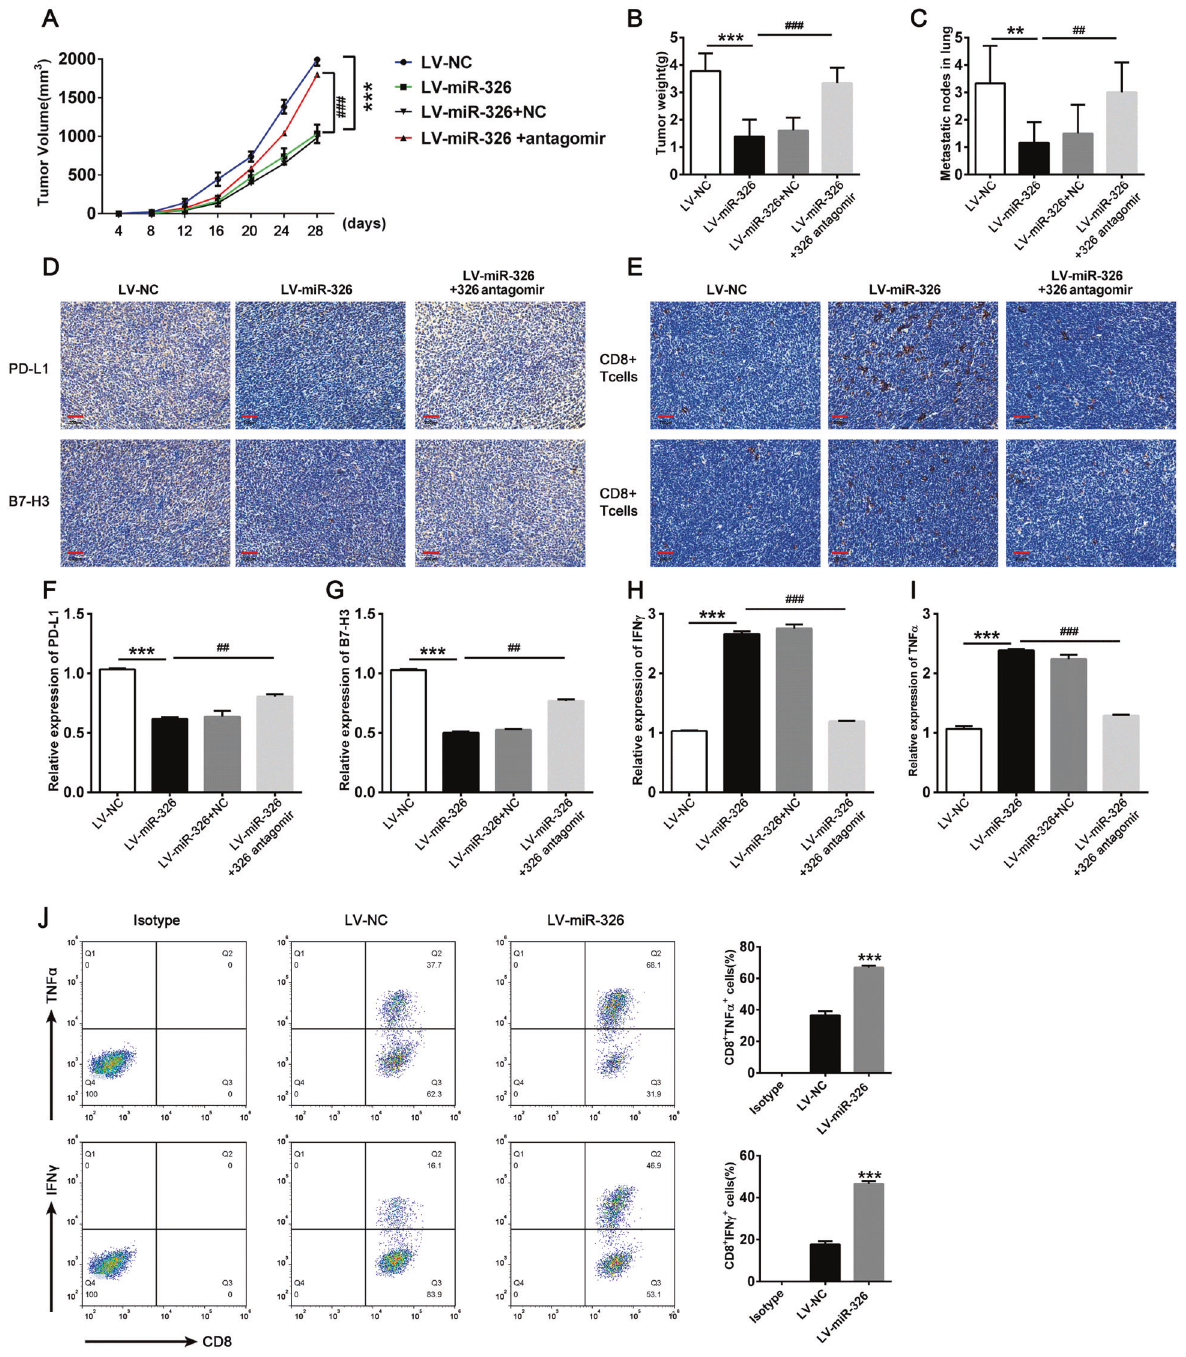
Fig. 6 Overexpression of miR-326 enhances TNF- α and IFN- γ expression of in fi ltrated CD8 + T cells and prevents metastasis by targeting PD-L1 and B7-H3 on cancer cells. 5 × 10 5 miR-326 overexpressed LLC cells or empty vector control LLC cells were subcutaneously injected into C57BL/6 mice. MiR-326 antagomir or NC antagomir were intratumor injected when the tumor diameter reached 0.5 cm. The mice were sacri fi ced 28 days after inoculation. A Tumor volume ( n = 7). B Tumor weight ( n = 6). C Pulmonary metastasis nodule calculated by hematoxylin – eosin staining. ( n = 6) D , E PD-L1, B7-H3 expression, and CD8 + T cells in fi ltration were determined by IHC staining in tumor tissues. F – I PD-L1, B7-H3, TNF- α , and IFN- γ were detected by qRT-PCR in tumor sites ( n = 3). J TNF- α and IFN- γ expression of in fi ltrated CD8 + T cells by fl ow cytometry ( n = 3). All data were presented as mean ± SEM. Comparisons between groups for statistical signi fi cance were performed with one-way ( B , C and F – I ) or two-way ( A ) ANOVA with Tukey ’ s post hoc test or Student ’ s t test ( J ). * P < 0.05, *** P < 0.001 versus LV- NC. # P < 0.05, ## P < 0.01, ### P < 0.001 versus LV-miR-326. Scale bar, 200 group (Fig. 6D). Then, we performed IHC staining for CD8 + T cells taken for IHC staining after the mice were sacri fi ced to detect PD- L1 and B7-H3 expression. As expected, PD-L1 and B7-H3 were in fi ltrated in tumor sites. Obviously, miR-326 overexpression lower in the miR-326 overexpression group than that in miR-NC tumor tissues showed more CD8 + T cells in fi ltration (Fig. 6E).